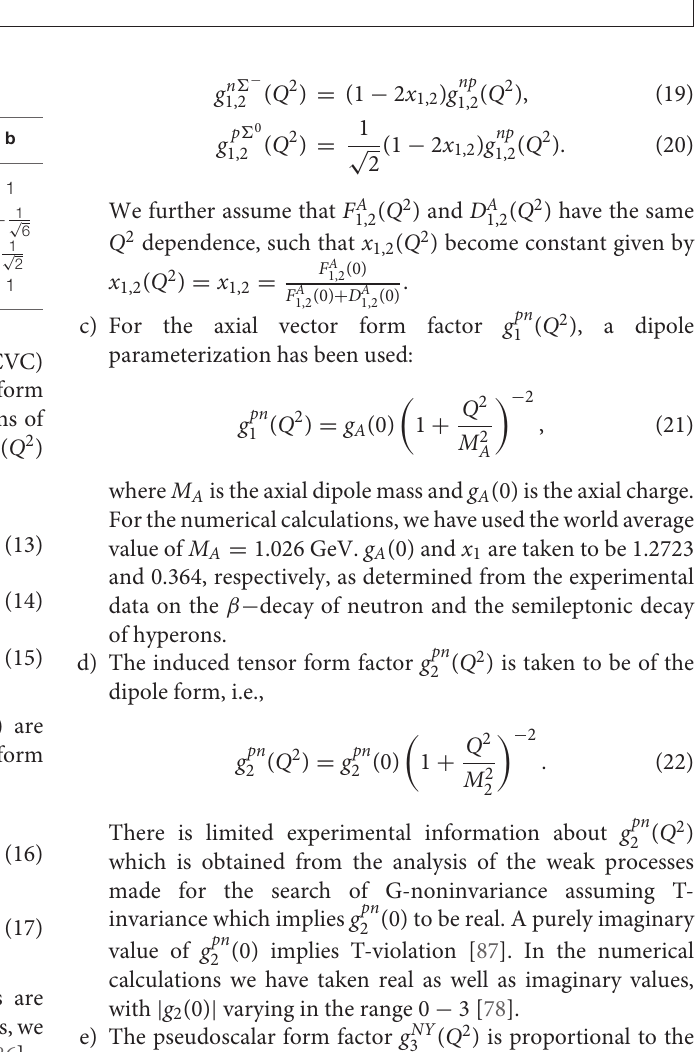
N ( p ) Y ( p ′ ) (left) and (B) ν µ ( k ) µ + ( k ′ ) ¯ + −→ +